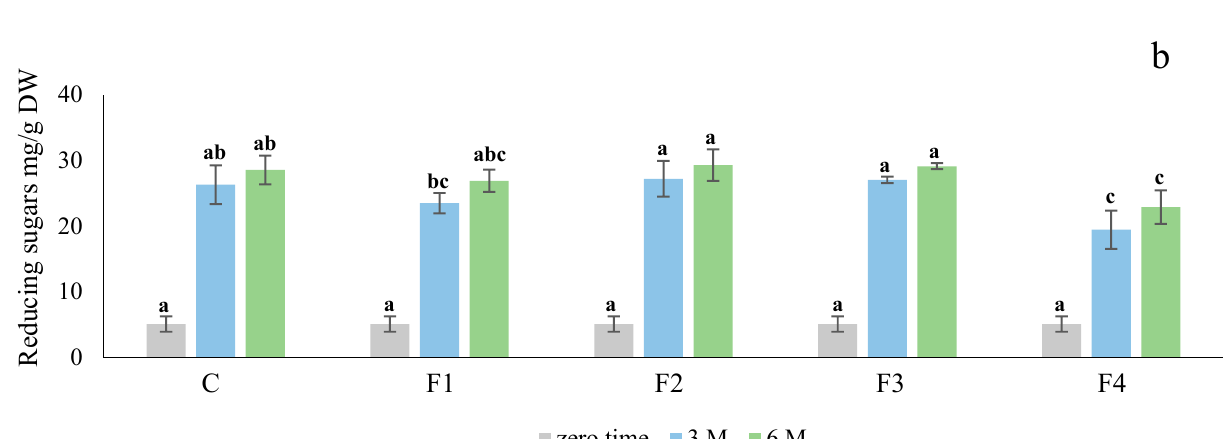
Figure 2. Effect of different edible coatings on the concentration of reducing sugars in Ciklamen ( a ) and Modoc ( b ) after six months of cold storage at 4 ± 2 °C and 90 ± 5% RH. Data are expressed as mean ± SD, n = 3. The different letters are letters on the bars are indicative of statistical significance ( p <0.05). C: control. F1: sodium alginate. F2: potato starch + sodium alginate emulsion with oregano oil. F3: zein + chitosan emulsion with oregano oil. F4: potato starch + chitosan + sodium alginate emulsion with oregano oil.